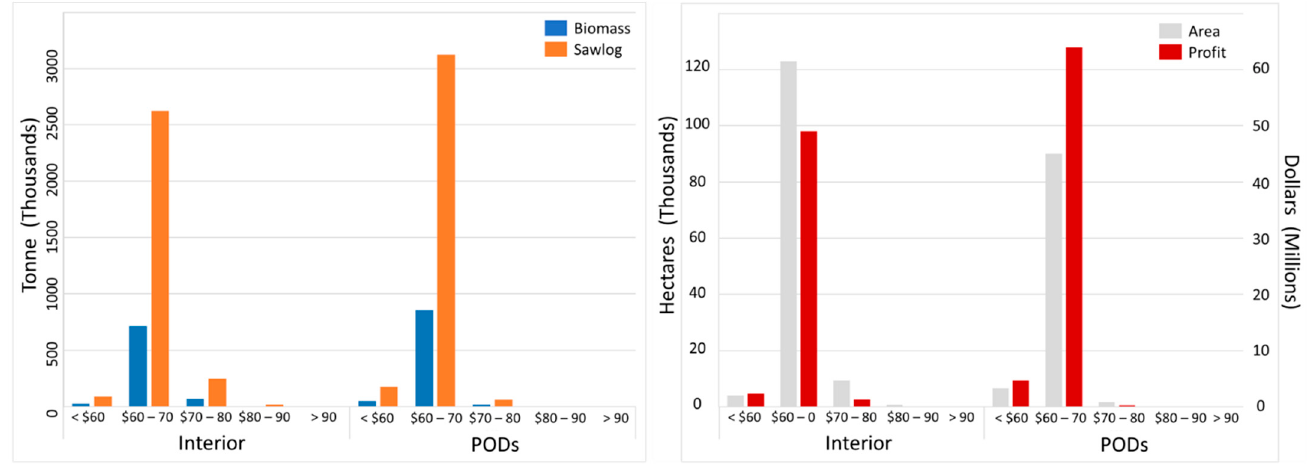
Figure 11. Supply chain by product type, implementation cost zones ( x -axis), and prescription (left graphic) and area treated ( y -axis 1) and profit margin ( y -axis 2) by implementation cost zones ( x -axis) and prescription (right graphic) graphs.